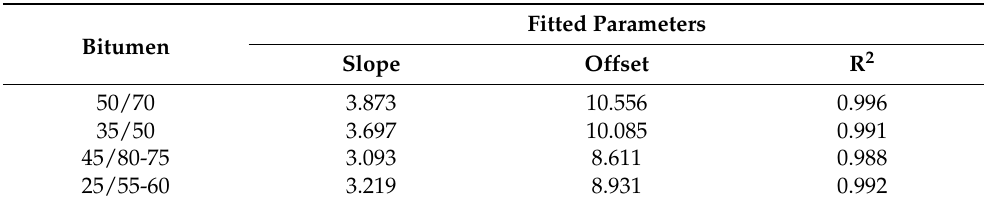
Figure 6. Viscosity–temperature relationship of tested bitumen samples. Table 1. Average values of fitted parameters for a viscosity–temperature model of 50/70 grade and 35/50 grade bitumen and modified bitumen 45/80-75 and 25/55-60. Fitted Bitumen